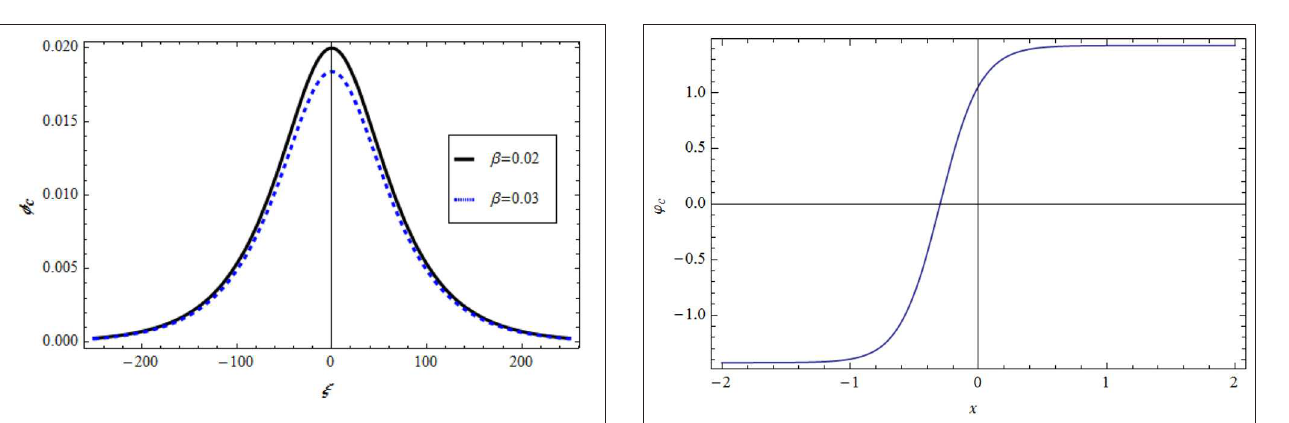
FIGURE 1 | Variation of φ c against χ , β for u